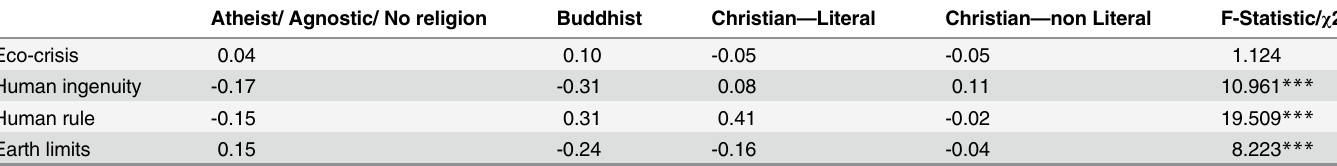
Table 5. Climate change beliefs across religious